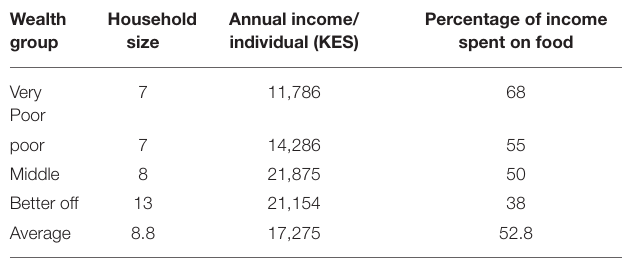
TABLE 3 | Characteristics of different wealth groups identified in